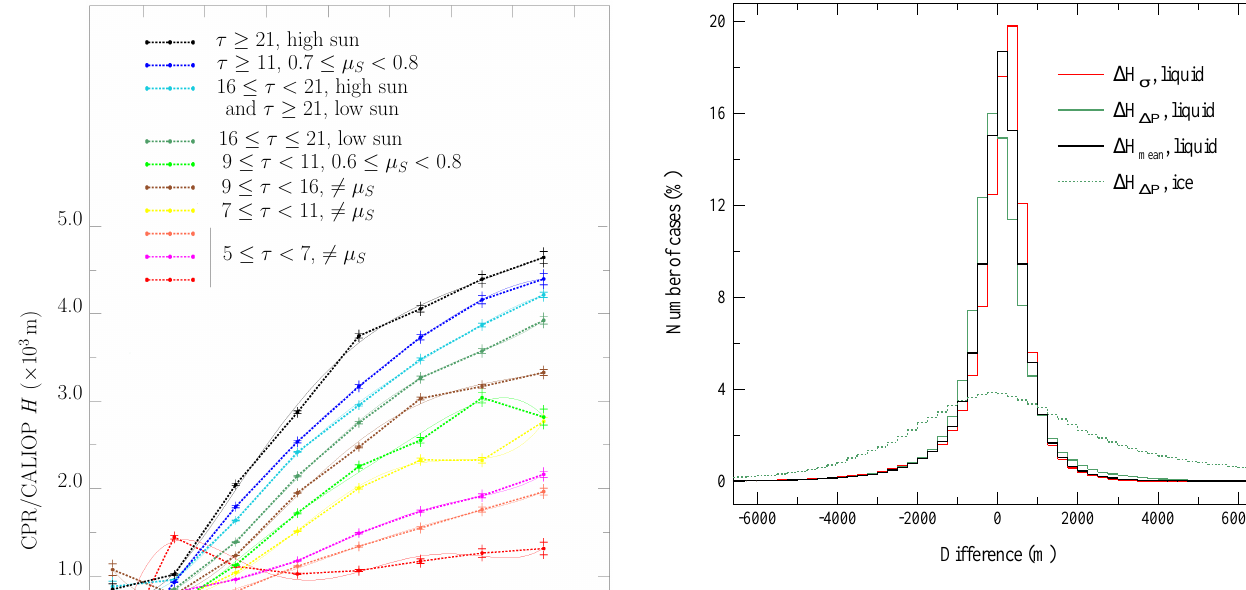
Fig. 12. Histogram of the difference between the CPR/CALIOP H and the retrieved h for liquid water clouds (solid line) and ice clouds (dashed line) over ocean in 2008. For the red curve (green), h was retrieved from σ P (from 1P ). For liquid water clouds, the black O2 curve shows the difference between the mean retrieval H mean and H (see text for Fig. 11. Average relation ( H , σ P ) and fifth-order fits by classes of O2 τ and µ s . Cases of monolayered liquid clouds in 2008 over ocean, with τ ≥ 5 and cc ≥ 0 . 95